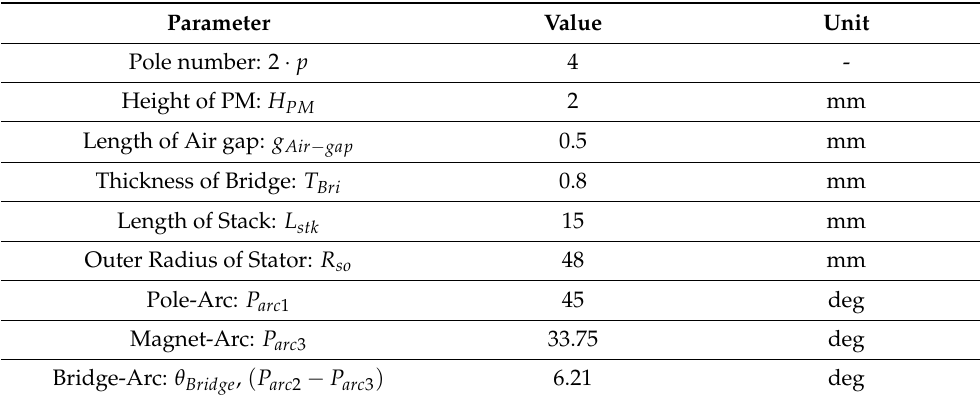
Table 1. Parameters for the equivalent magnetic circuit method for considering the magnetic satura- tion in the bridge